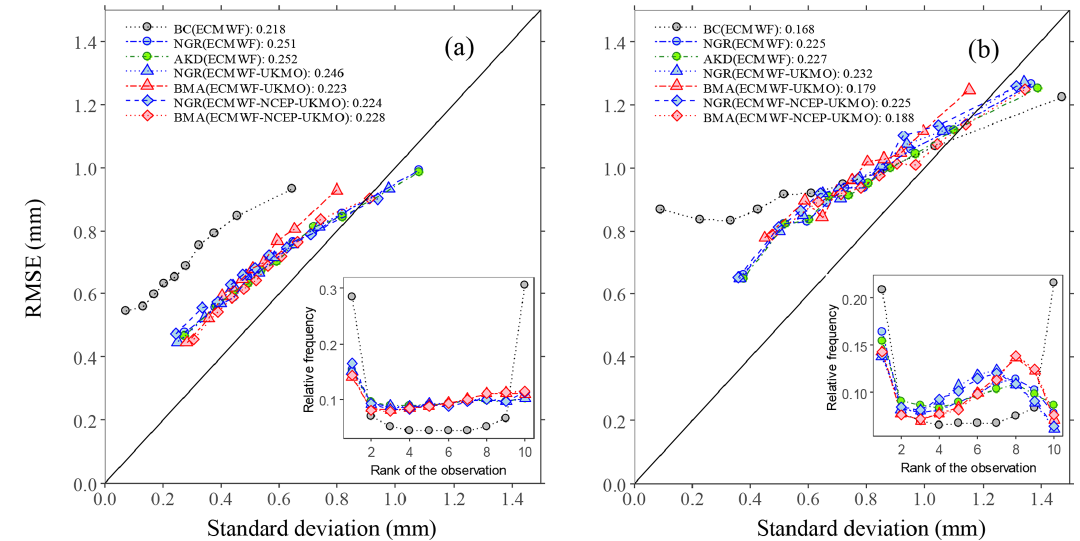
Figure 3. Binned spread–skill plots accounting for the mean of the ensemble standard deviation deciles against the mean RMSE of the forecasts in each decile over the verification period based on all pairs of forecasts and observations at lead times of (a) 1d and (b) 7d. The inset panels show the corresponding rank histograms. The correlation between the standard deviations and the absolute errors is included in the legend. The solid line represents the 1 : 1